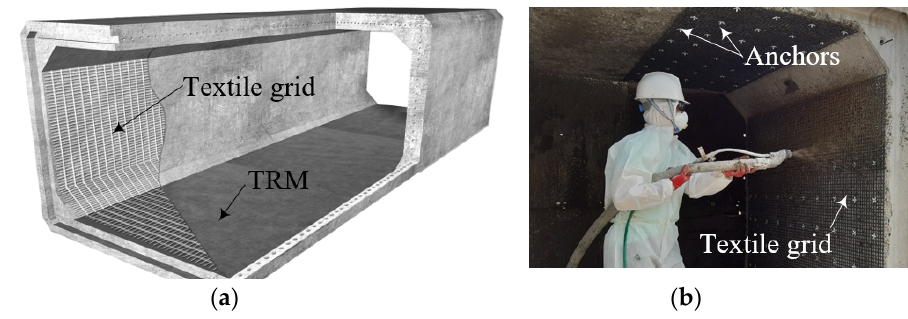
Figure 1. Typical installation methods: ( a ) hand lay ‐ up; and ( b ) shotcreting (spraying).